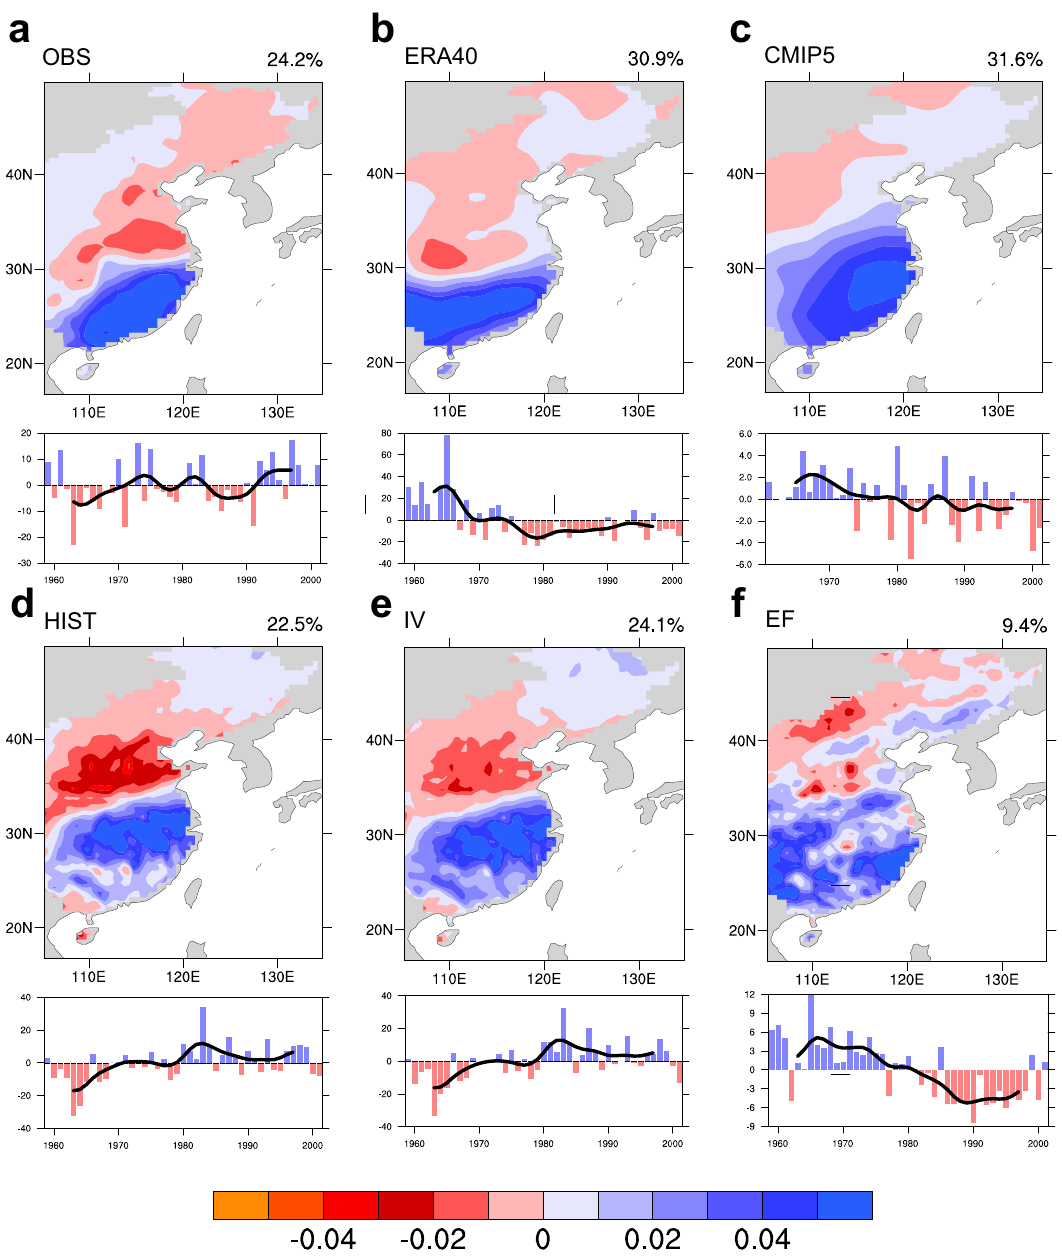
Fig. 2 Spatial patterns of the fi rst leading empirical orthogonal functions and time series of the principal components in the annual mean precipitation during the time period 1959 – 2001 in eastern China. a Observational data (CN05.1 and APHRO), b ERA40 reanalysis data, c the MME of 17 CMIP5 models, d the WRF historical (HIST) run, e the WRF internal variability (IV) run, and f the response to external forcing (EF). The black thick solid lines are 9-year running mean of the principal